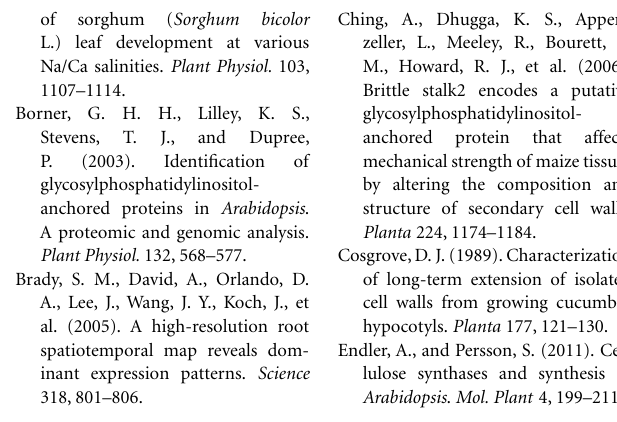
FIGURE 4 | Spatial distribution patterns of protein abundances for (A) cellulose synthases, (B) glycosyltransferases, (C) brittle stalk-2-like protein 3, and (D) fasciclin-like arabinogalactan proteins in R1–4 of the